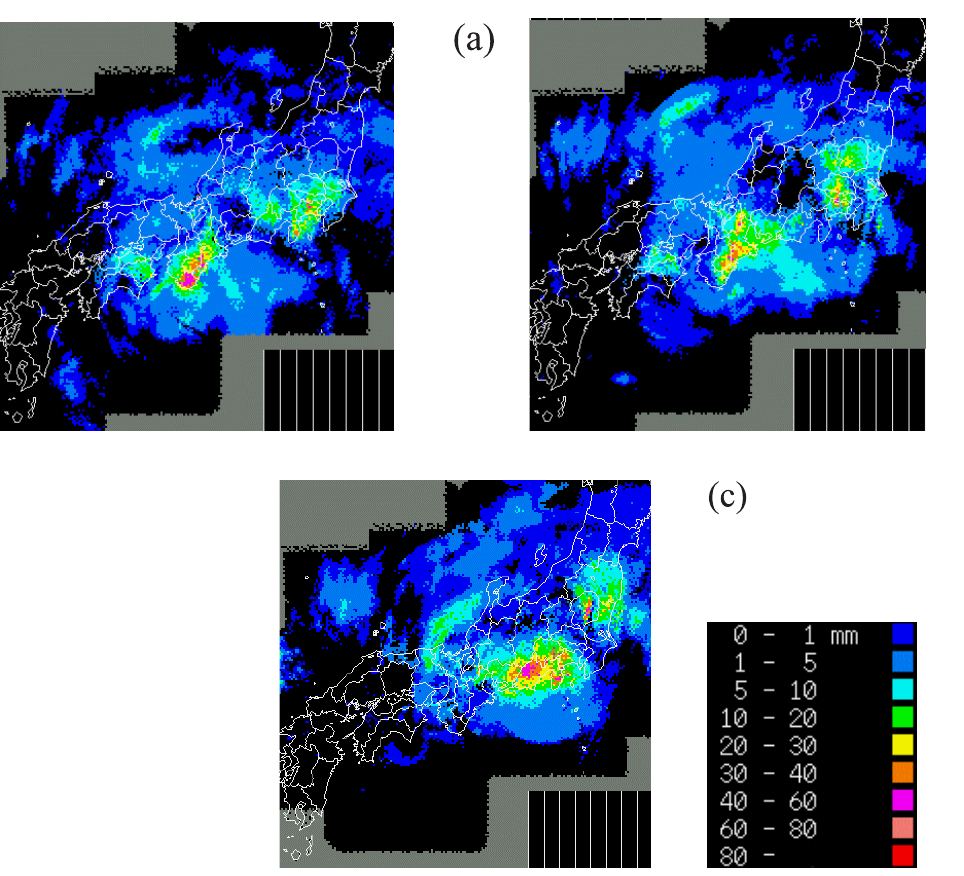
Fig. 2. Horizontal distributions of the amount of rainfall for (a) 05–06 LT, (b) 07–08 LT, and (c) 09–10 LT on 20 June